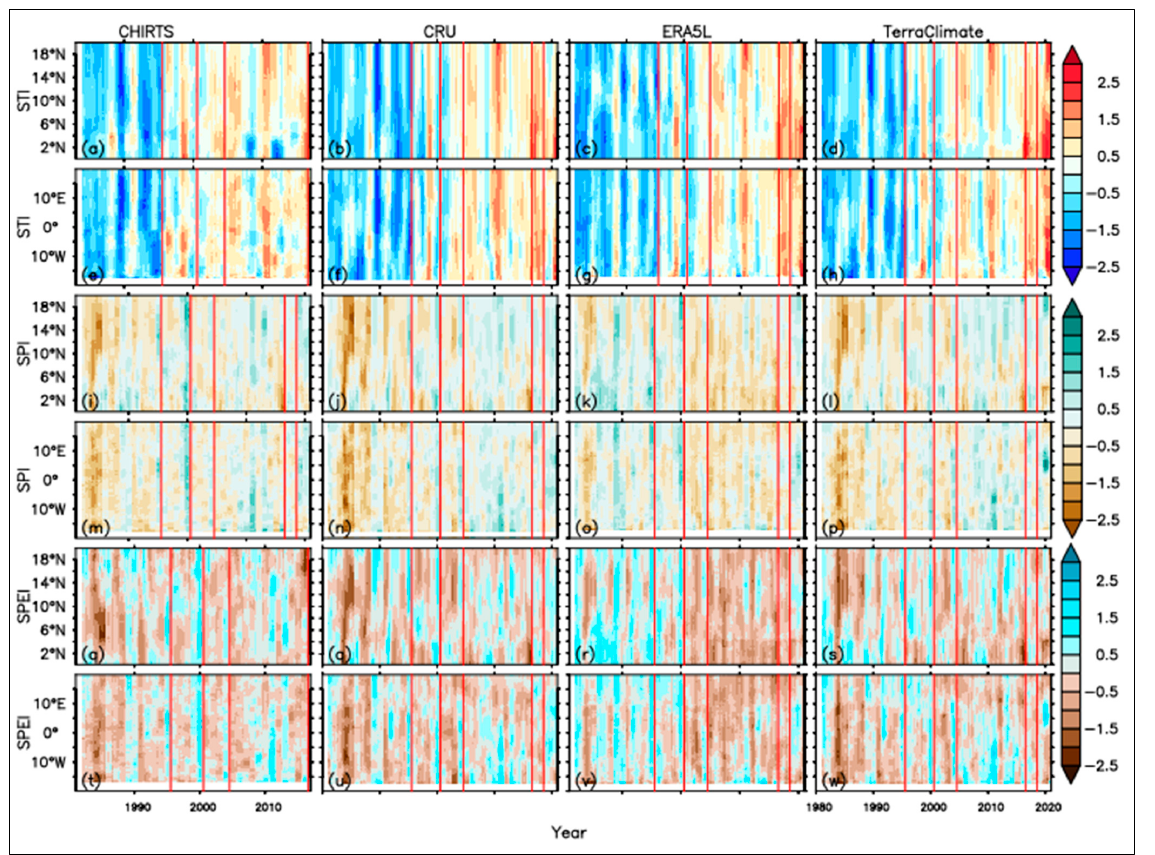
Figure 8. Time-latitude and time-longitude Hovmoller diagrams over West Africa showing that land cover changes (in red) coincide with abrupt climatic changes. ( a – h ) how STI values varies with time along the latitude and longitude respectively for CHIRTS, CRU, ERA5-Land, and TerraClimate datasets. ( i – w ) how STI values varies with time along the latitude and longitude respectively for SPI and SPEI.